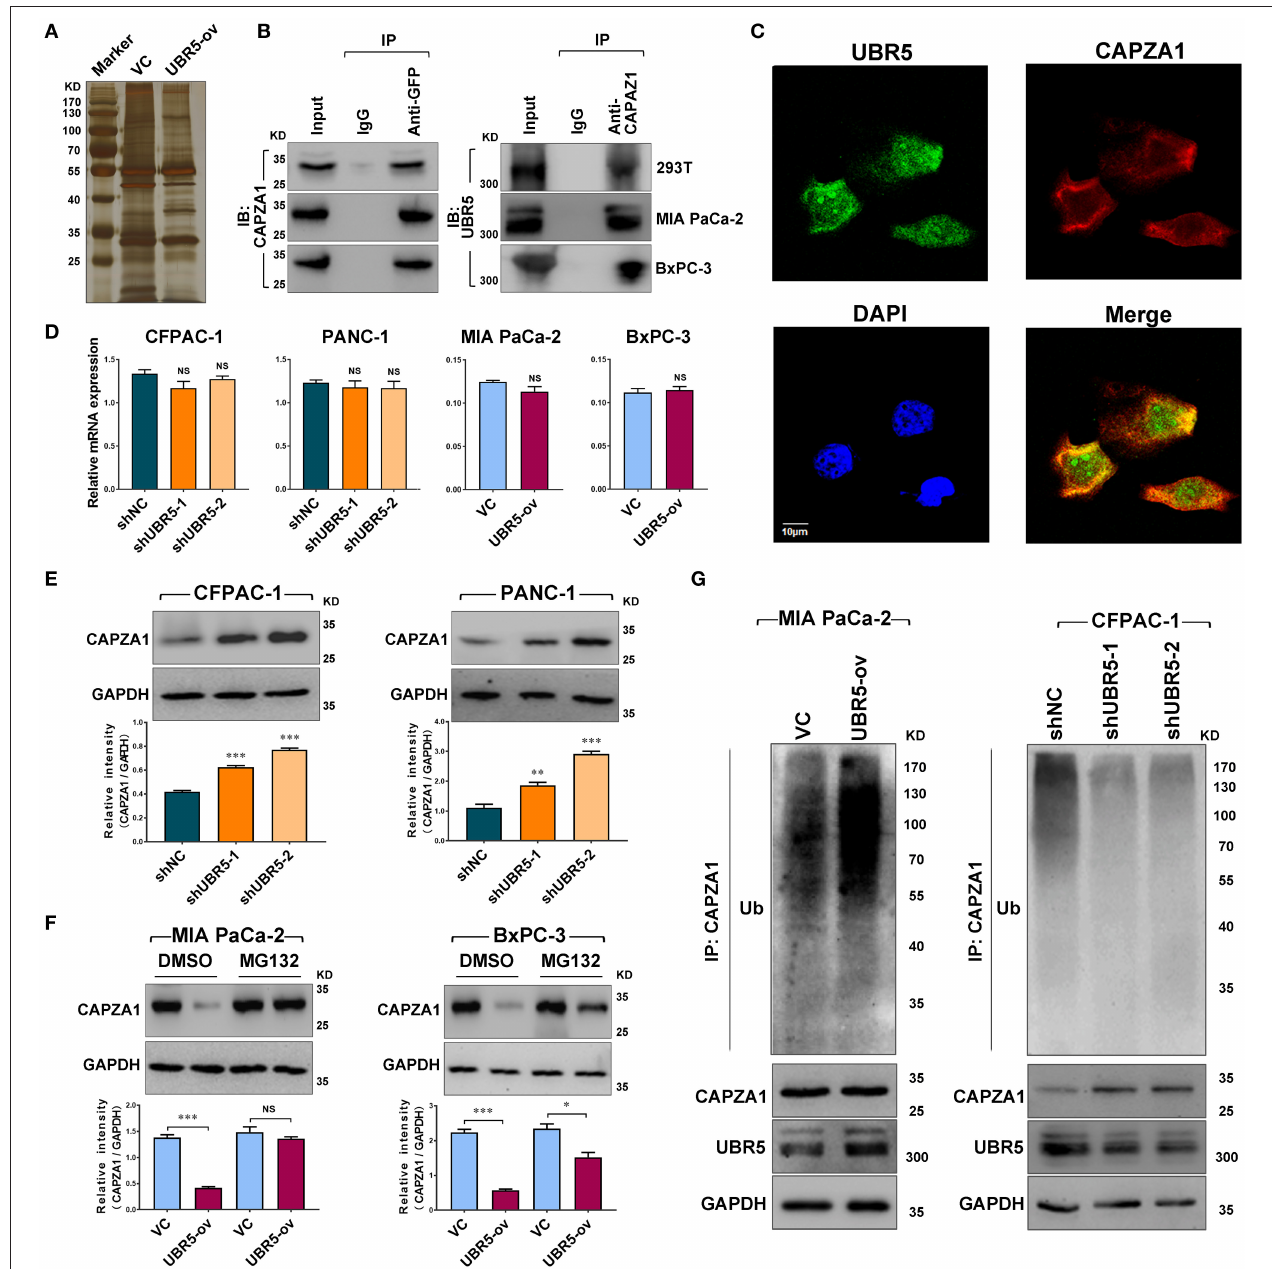
FIGURE 3 | UBR5 interacts with and destabilizes CAPZA1. (A) Immunoprecipitation and the silver staining assay in UBR5-binding proteins. The vector control (VC) or GFP-tagged UBR5 (UBR5-ov) plasmid was transfected into HEK-293T cells, and anti-GFP antibody was used to immunoprecipitate UBR5-binding proteins. The immunoprecipitates were separated on SDS-PAGE and stained by silver staining. (B) The associations between UBR5 and CAPZA1. HEK-293T, MIA PaCa-2 and BxPC-3 cells were transfected with the plasmid encoding GFP-tagged UBR5 and immunoprecipitation was carried out for the detection of the associations between UBR5 and CAPZA1. (C) The cellular co-localization of UBR5 and CAPZA1 in CFPAC-1 cells. Scale bar = 10 µ m. (D) The relative mRNA expression of CAPZA1 in CFPAC-1, PACN-1 cells infected with shUBR5 and in MIA PaCa-2, BxPC-3 transiently overexpressing UBR5. (E) The protein level of CAPZA1 assessed by western blot in CFPAC-1 and PANC-1 cells infected with shUBR5 or shNC. (F) The relative CAPZA1 protein levels in UBR5-overexpressing MIA PaCa-2 and BxPC-3 treated with DMSO or MG132. (G) The ubiquitination level of CAPZA1 in UBR5-overexpressing MIA PaCa-2 cells or UBR5-knockdown CFPAC-1 cells treated with MG132. Data represents mean ± SEM (n = 3 independent biological repeats). NS, not significant; *, P < 0.05; **, P < 0.01; ***, P < 0.001.